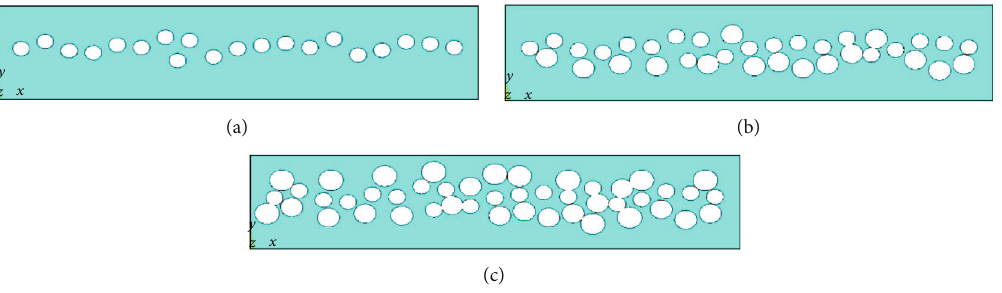
Figure 3: Simulation of three pitting degrees. (a) Degree . (b) Degree 2. (c) Degree 3.